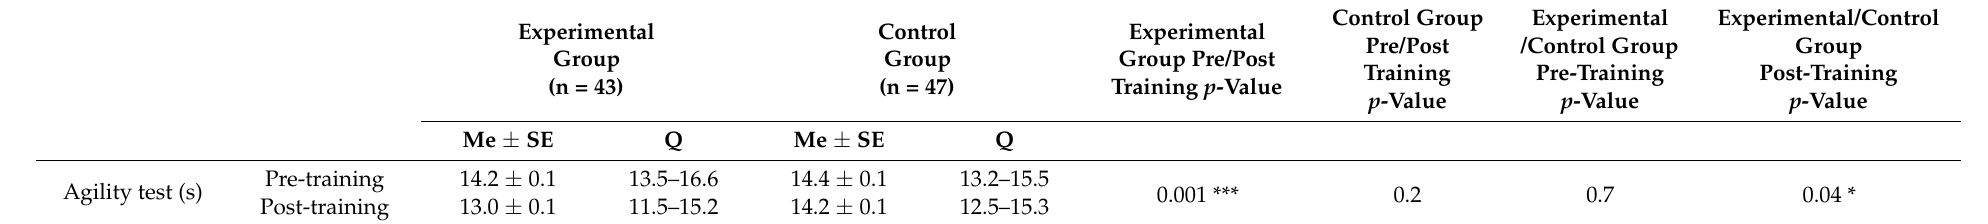
Table 4. Effect of a 10-week sensorimotor exercise program on